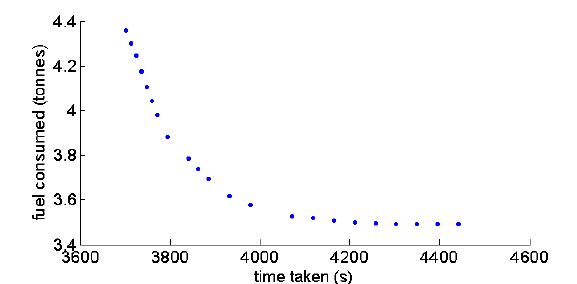
Fig. 2: Pareto frontier for minimum time and minimum fuel burn.